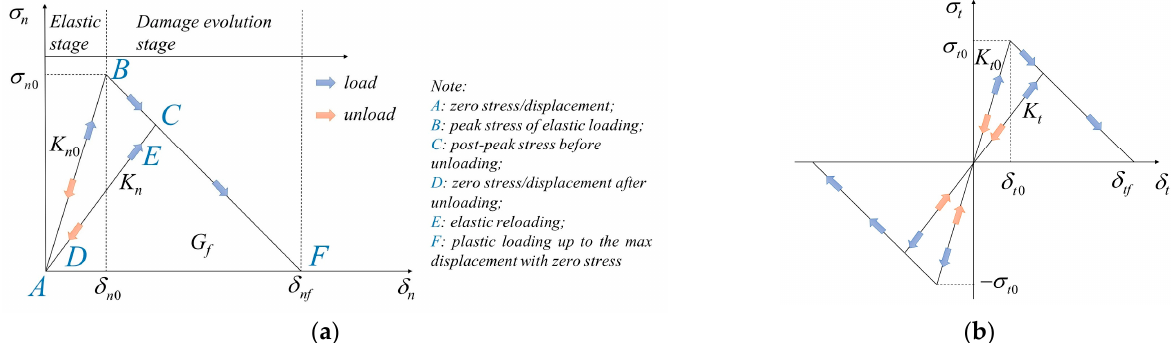
Figure 1. Bilinear constitutive relation between traction and separation. ( a ) Normal direction; ( b ) shear direction.